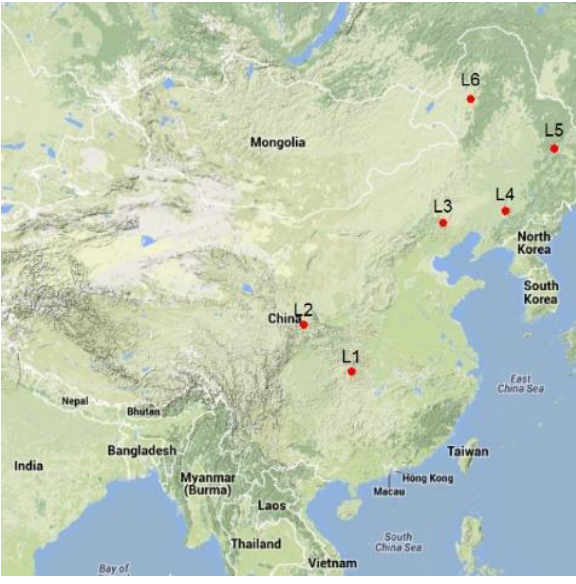
Figure 1. Six larch plantation regions in China.